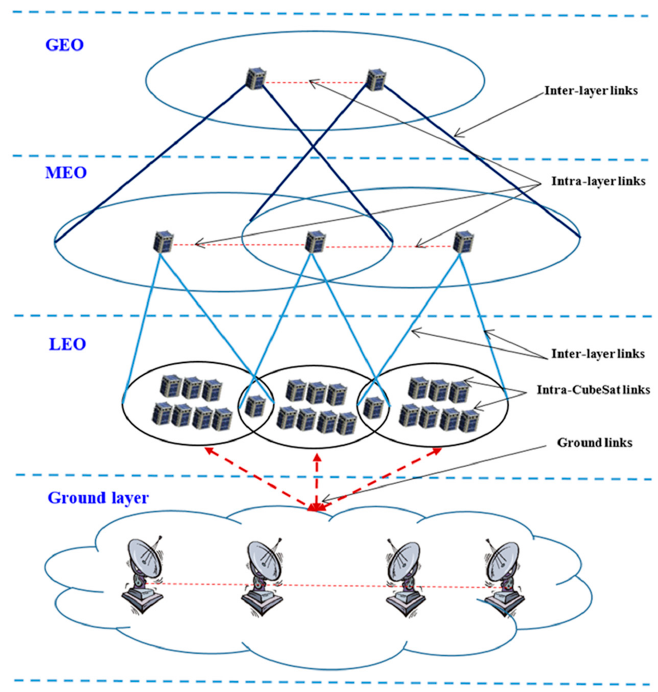
Figure 5. Multi-layer satellite network hierarchy.